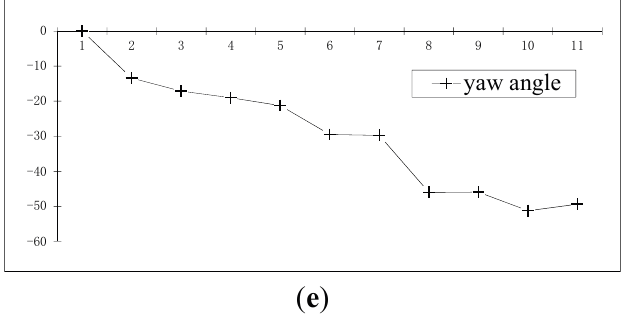
Figure 13. The recovery of the moving car. ( a ) The distance value of T1T2 at each point in time; ( b ) The trajectory reconstruction results of two moving points on the car in the XY plane; ( c ) Those in the Z direction; ( d ) The measurement results of the pitch angle of the car; ( e ) The measurement results of the yaw angle of the